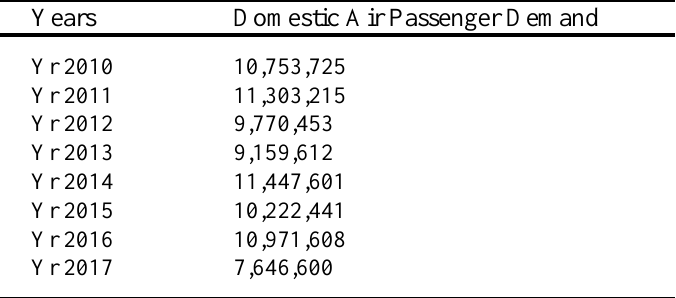
Table 1. Demand for Nigeria Domestic Air Passengers in the Past Eight Years [13, 14,